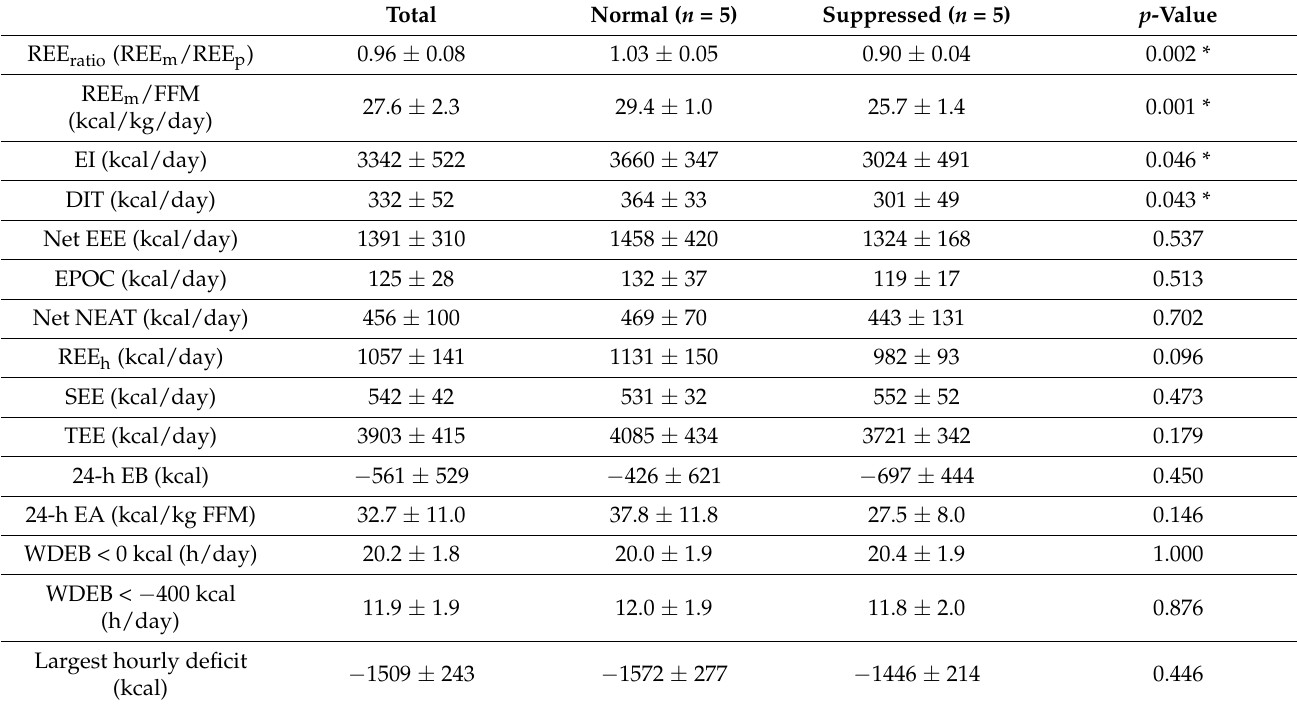
Table 2. REE ratio , EI, EE components, and WDED variables of the participants during total 7 day in